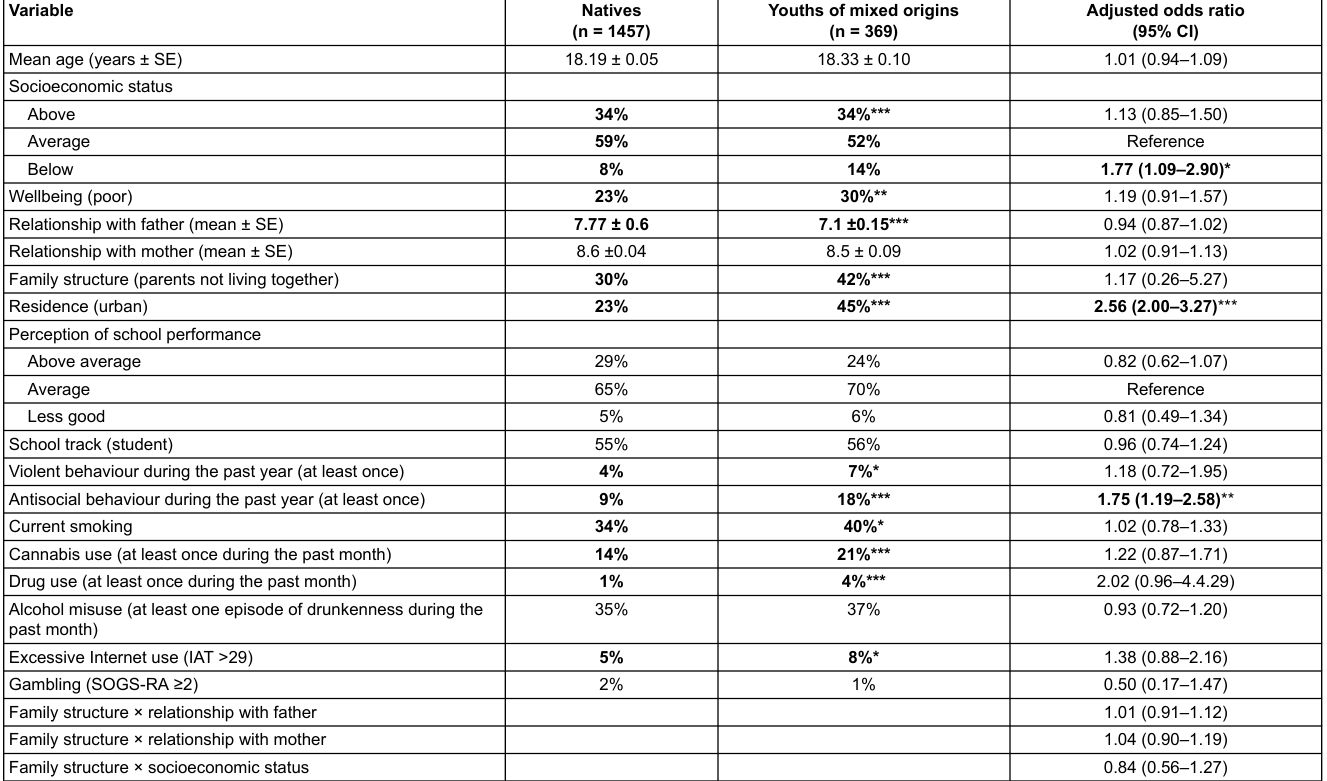
Table 6: Girls: comparison of youths of mixed origins vs natives in the age group 15–24 years in post-mandatory